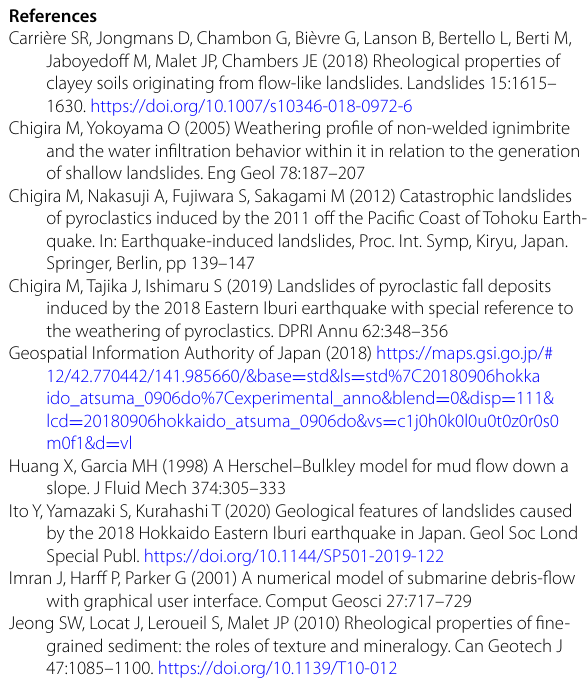
1554 Pa, µ 2200 Pa s). Grey arrows indicate the movement direction of the = =